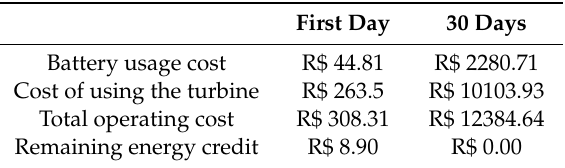
Table 4. Operating data for scenario 2.